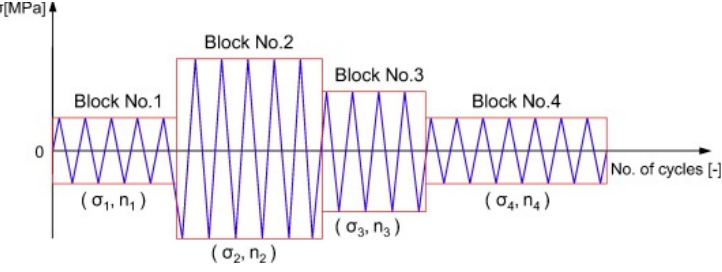
Figure 1. Typical block loading sequence [14].